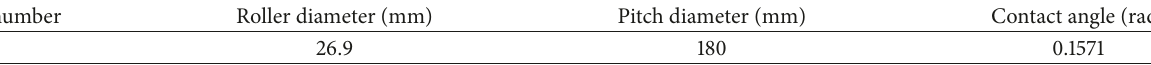
Table 1: The parameters of the test rolling